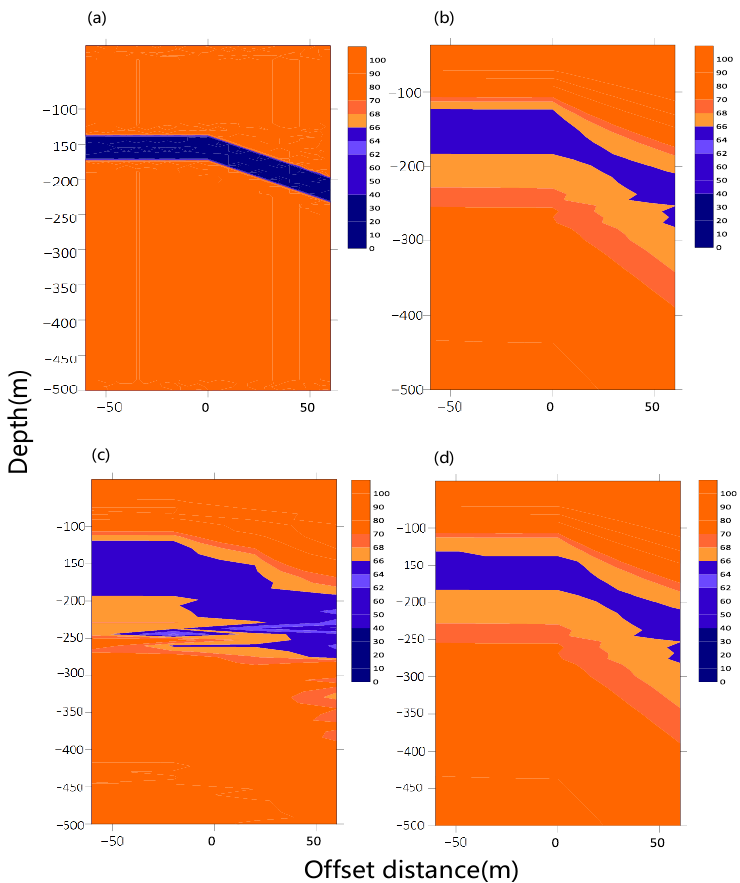
Figure 9. The apparent resistivity profiles of the quasi-two-dimensional earth model. ( a ) Theoretical model; ( b ) simulation data inversion result; ( c ) inversion result before de-noising; ( d ) inversion result after de-noising.